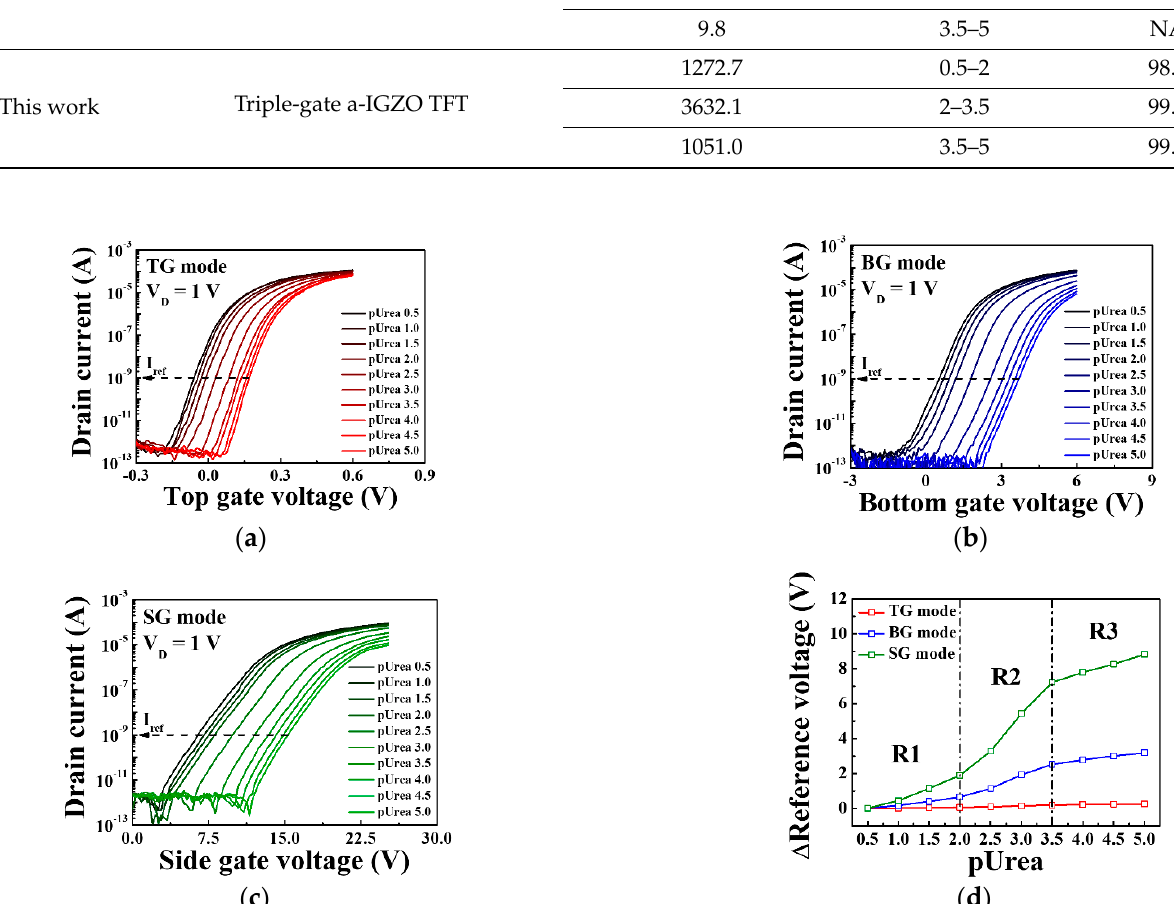
Figure 10. Transfer characteristic curves in urea-urea reactions of the triple-gate a-IGZO TFT-based urea-EnFET sensor